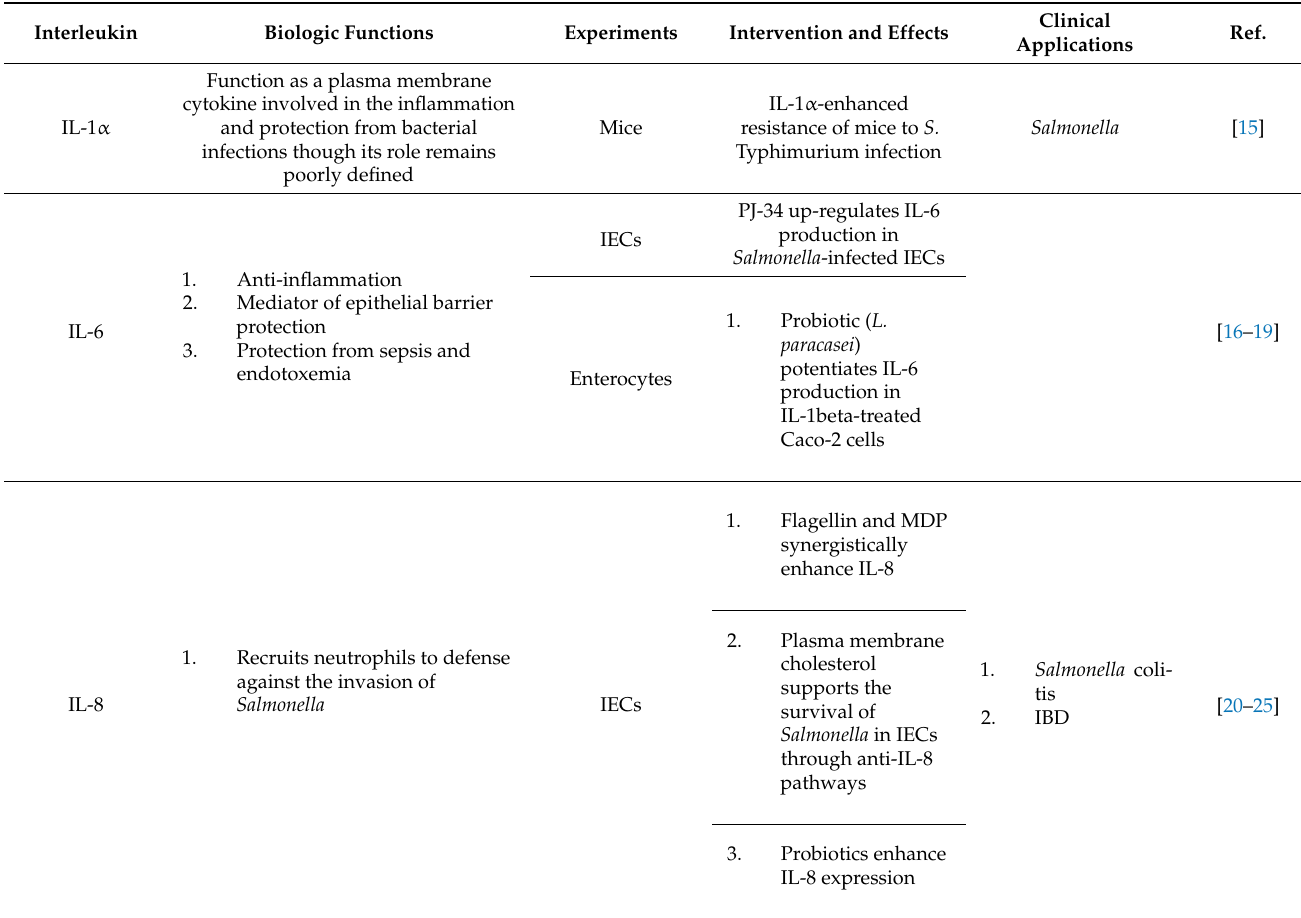
Clinical Applications